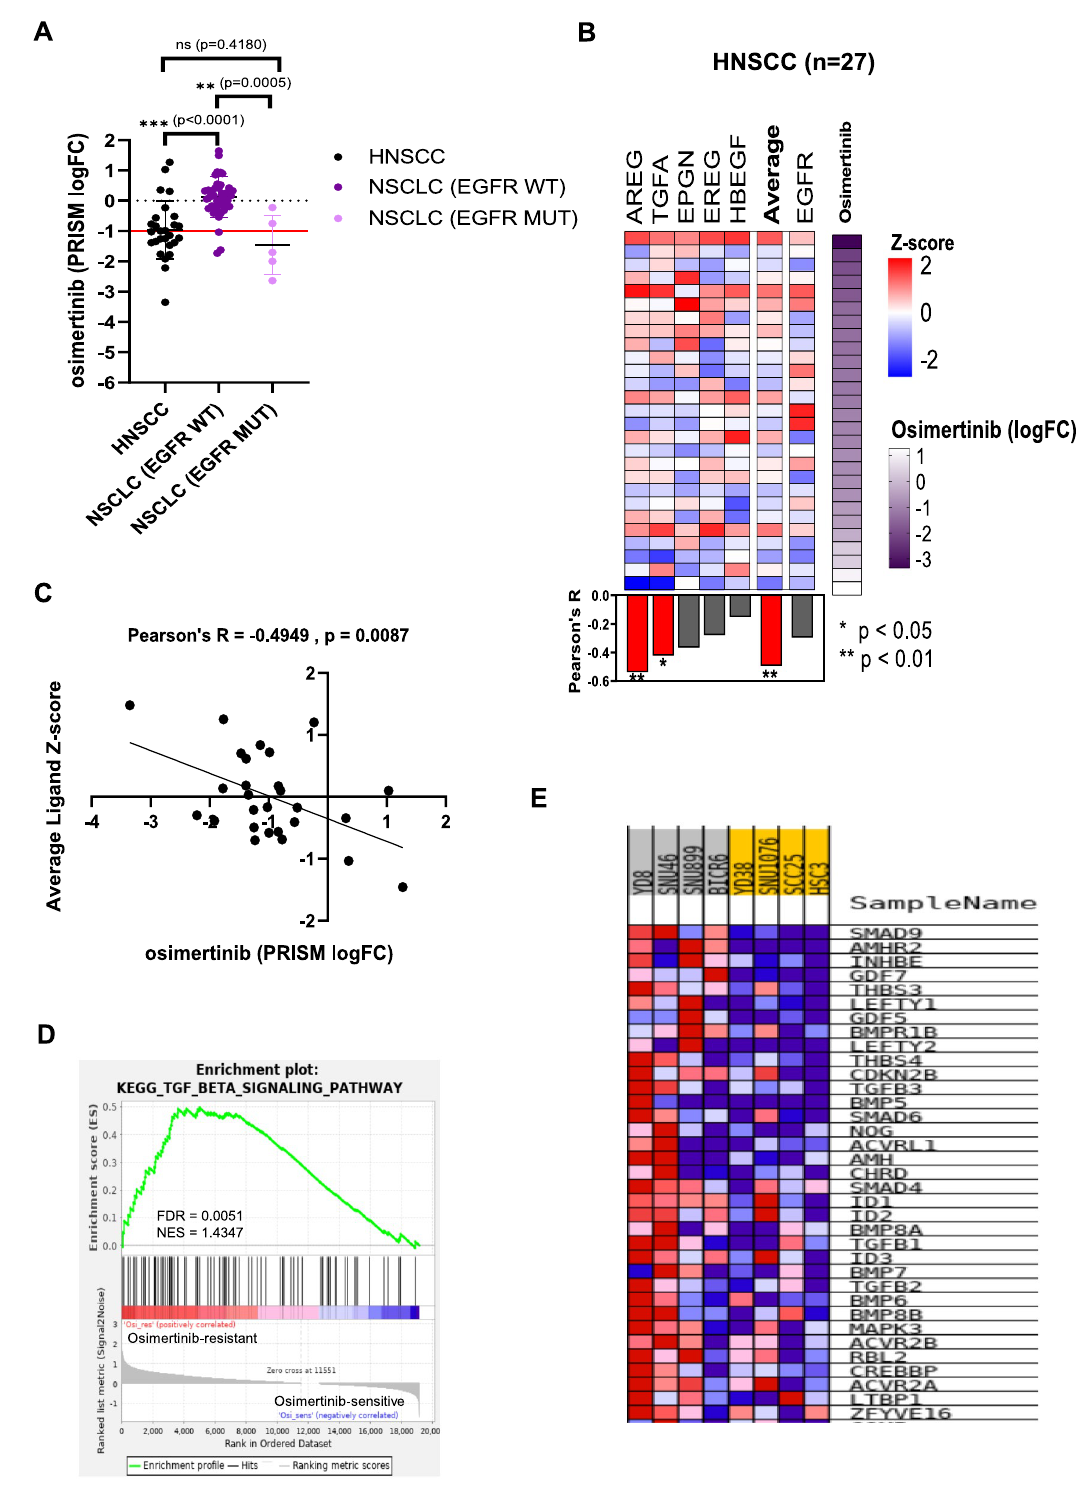
Figure 4. Identification of biomarker of response for osimertinib. ( A ) The mean logFC from the PRISM primary screen for osimertinib in HNSCC is comparable with NSCLC with EGFR mutations ( P = 0.4180). Both the clinically responsive subset (NSCLC with EGFR mutation) ( P = 0.0005) and unselected HNSCC ( P < 0.0001) have mean logFC that are significantly lower than the subset of NSCLC without EGFR mutation. ( B ) Pearson’s correlation of EGFR ligands (AREG, TGFA, EPGN, EREG and HBEGF) or EGFR gene expression with osimertinib sensitivity in 28 HNSCC cell lines (each row is a cell line). ( C ) Average EGFR ligands expression (Z-score) is significantly correlated with osimertinib sensitivity (logFC) (Pearson’s R = -0.4949, P = 0.0087). ( D ) Gene set enrichment analysis (GSEA) reveal significant upregulation of the TGF-beta signalling pathway among the osimertinib-resistant cell lines. ( E ) Gene expression heatmap from GSEA, showing the up-regulated genes within the TGF-beta signalling pathway. ( A ) to ( C ) were plotted using GraphPad Prism software 8.0.2. ( D ) and ( E ) were figures generated from running the GSEA modules from GenePattern 2 11 (https:// www. genep attern.